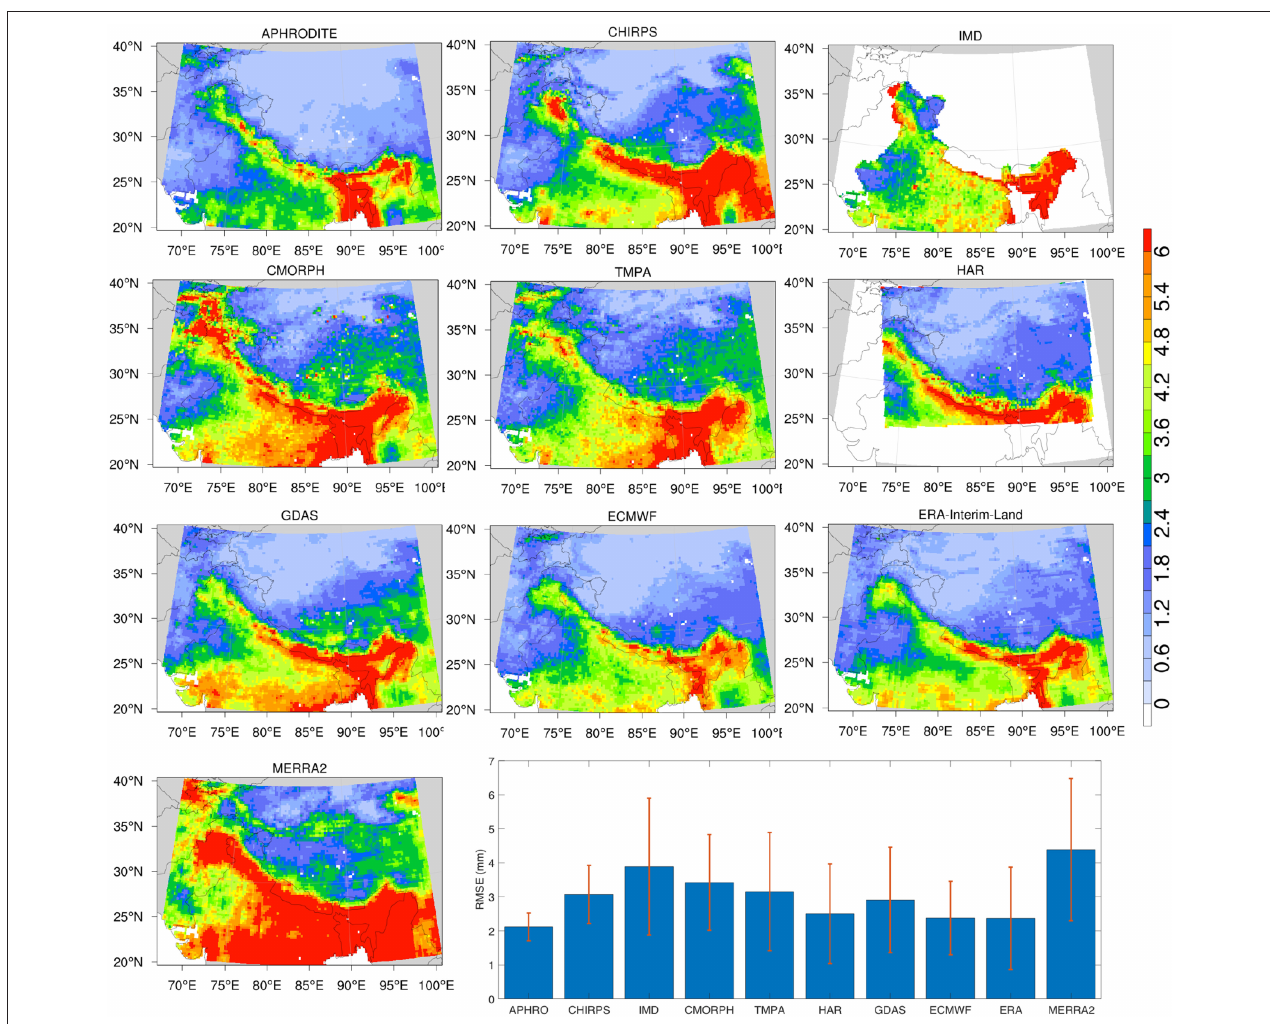
FIGURE 6 | RMSE of precipitation (mm) estimated using the ETC method. The value at each grid point represents the mean RMSE across 120 possible triplets among the 10 precipitation products. The error bars represent the mean standard deviation across the 120 triplets.